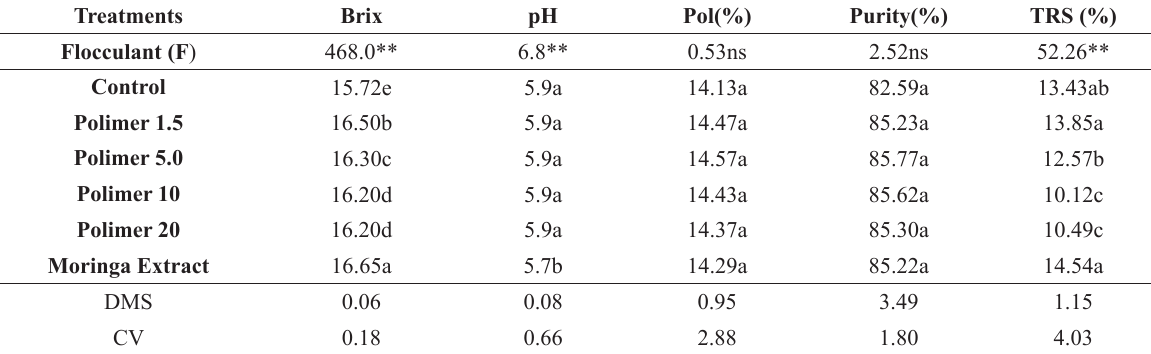
Mean values obtained for Brix, pH, Pol, Purity and TRS of the clarified juice with 5 different sedimentation aids, from CTC5 sugarcane variet. Jaboticabal-SP. 2015/2016 crop year.